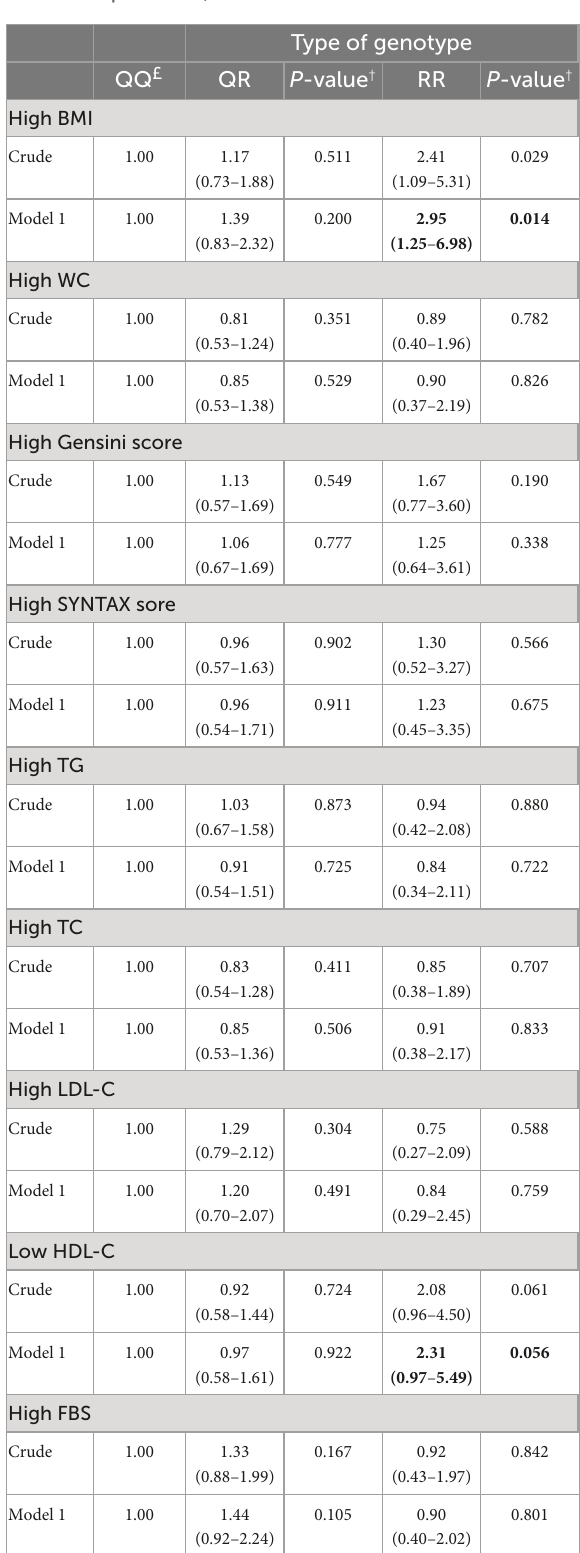
TABLE 3 Crude and multivariable-adjusted ORs (and 95% CIs) for the association of PON1 rs662 genotypes with anthropometric indices, biochemical parameters, and other CAD risk